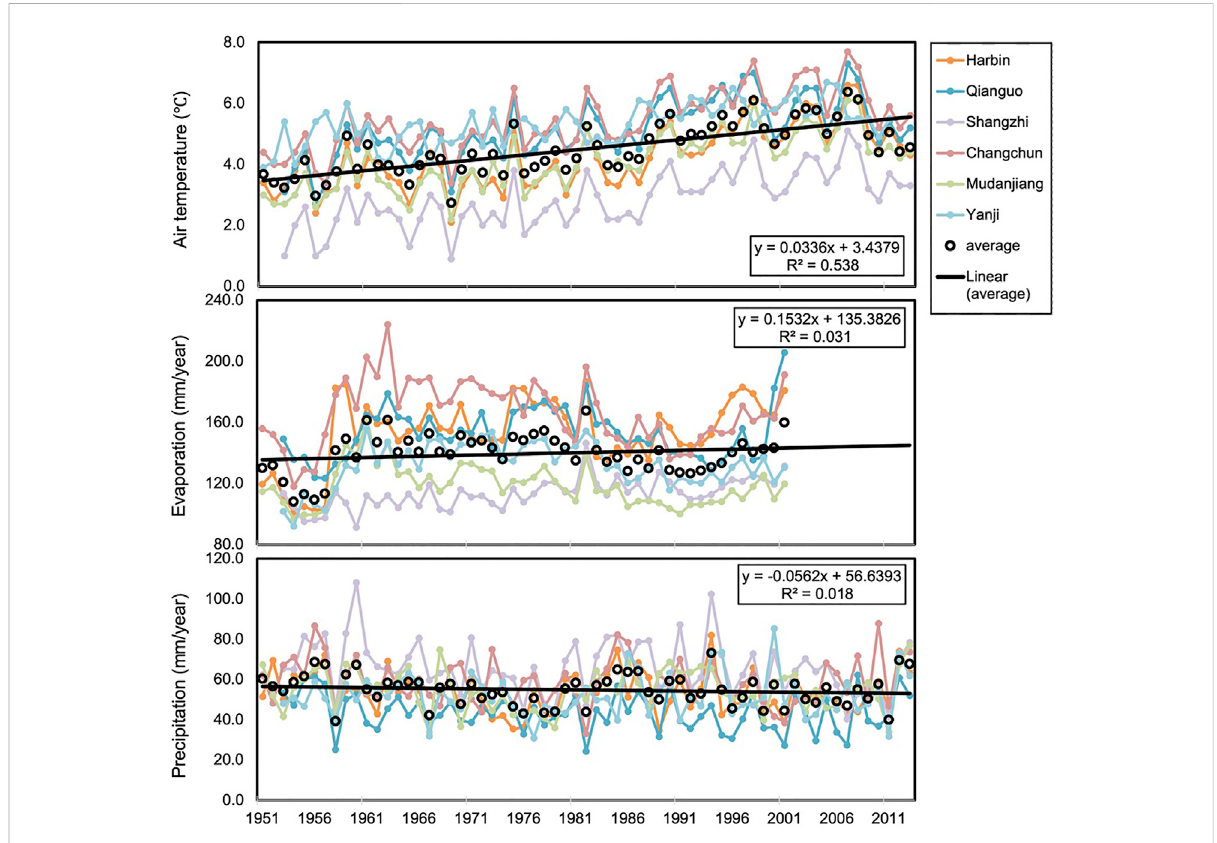
FIGURE 12 MeteorologicalvariationaroundtheLRB.Theaveragevalueofmeteorologicalstationswasplottedasblackcircleandisregressedasablackline showing the linear variation tendency (the signi fi cance level, p are less than 0.05 for all